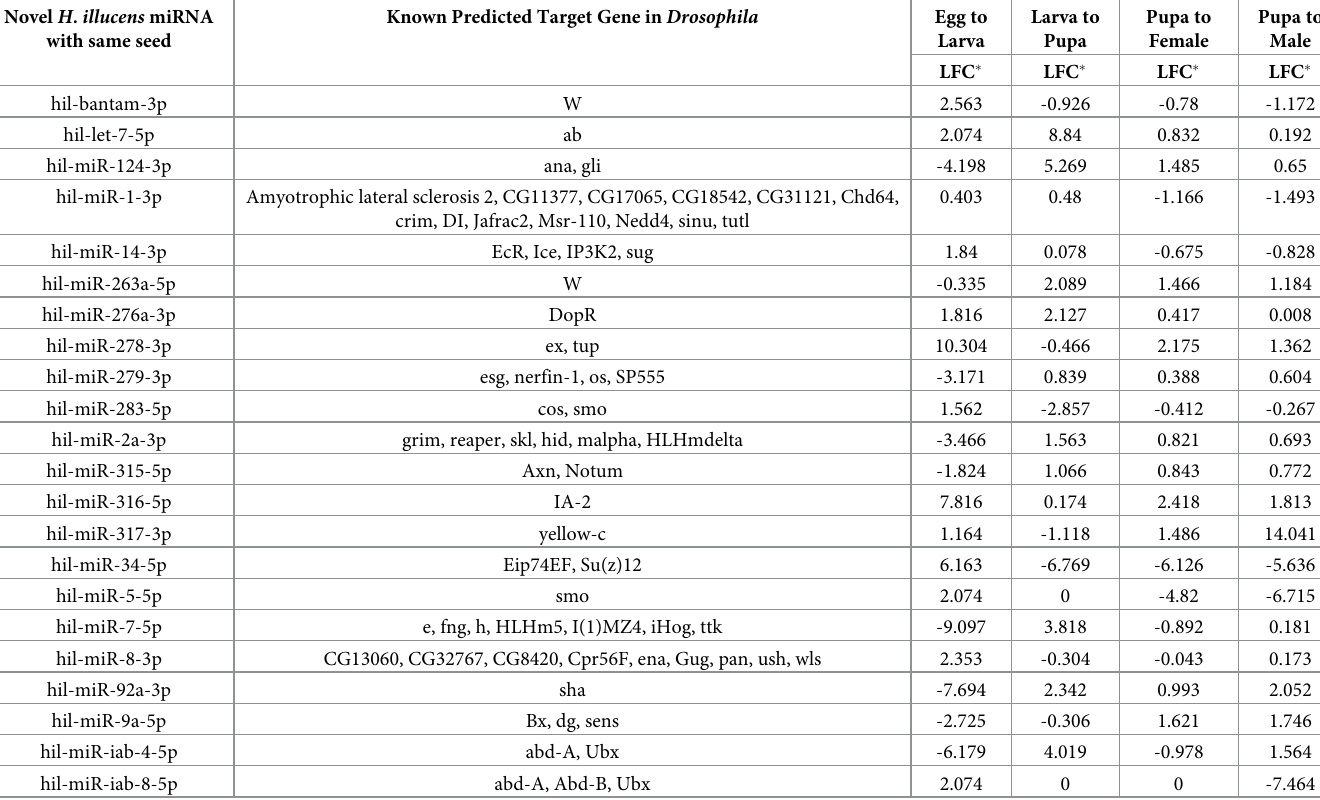
Table 4. Novel H . illucens microRNA with orthologous microRNA and their predicted target genes in Drosophila . Novel H . illucens miRNA with same